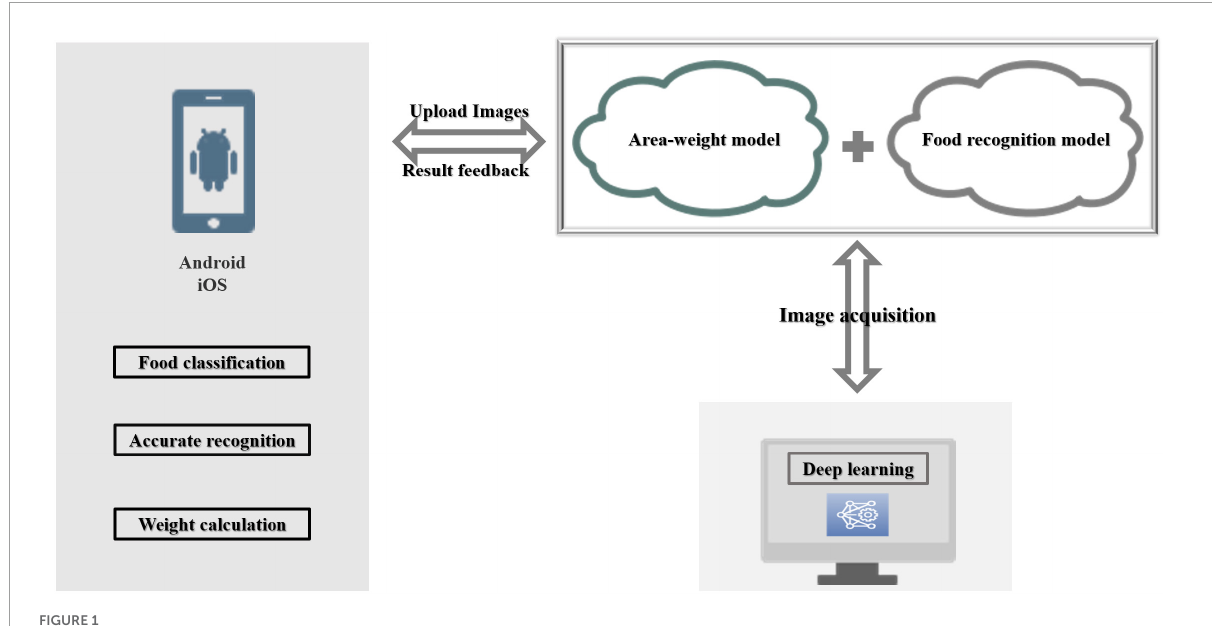
FIGURE1 Wearable dietary monitoring system for mobile terminal.